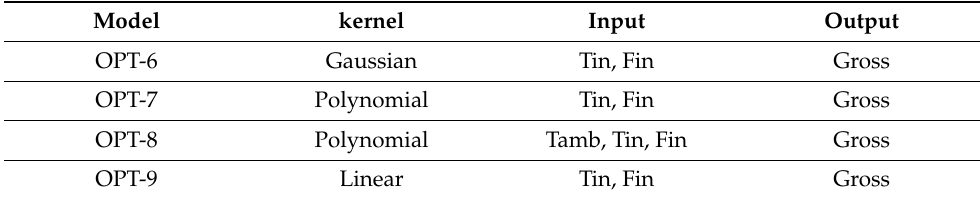
Table 3. Validation with Plant B data. T amb is the ambient temperature, Tin is PB inlet temperature and Fin is the PB inlet flow.